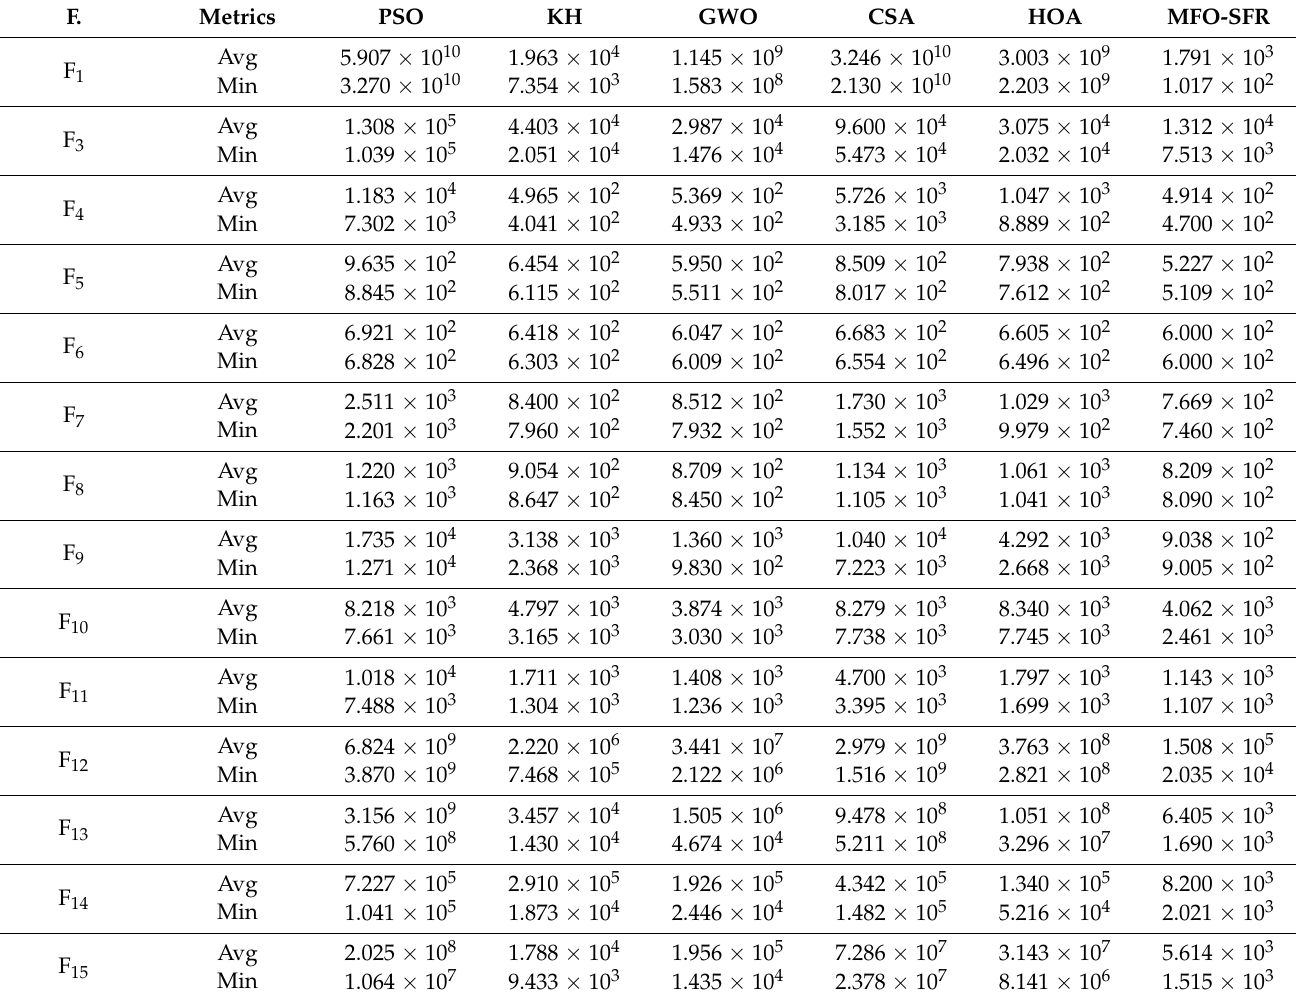
Table 5. Comparison of MFO-SFR with well-known algorithms for CEC 2018 test functions with D =